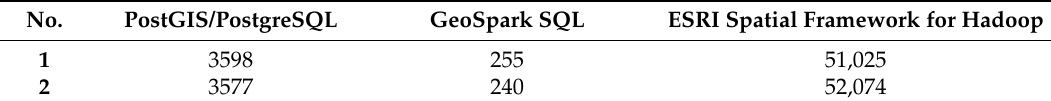
Table 7. Performance of kNN queries (in milliseconds).